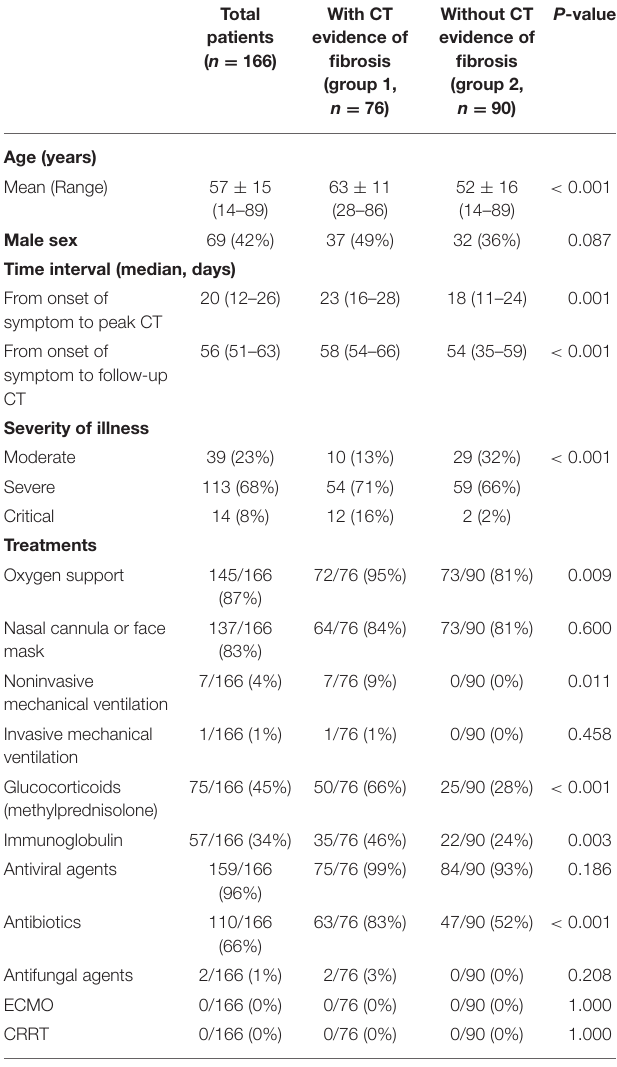
TABLE 2 | Characteristics and treatments of patients with COVID-19.